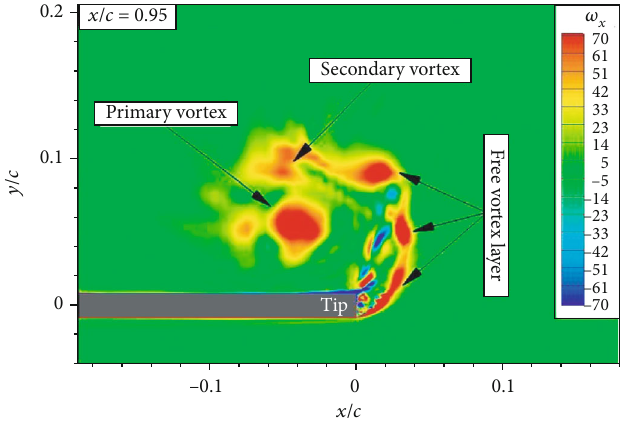
Figure 19: The instantaneous vorticity fi eld near the trailing edge of clean